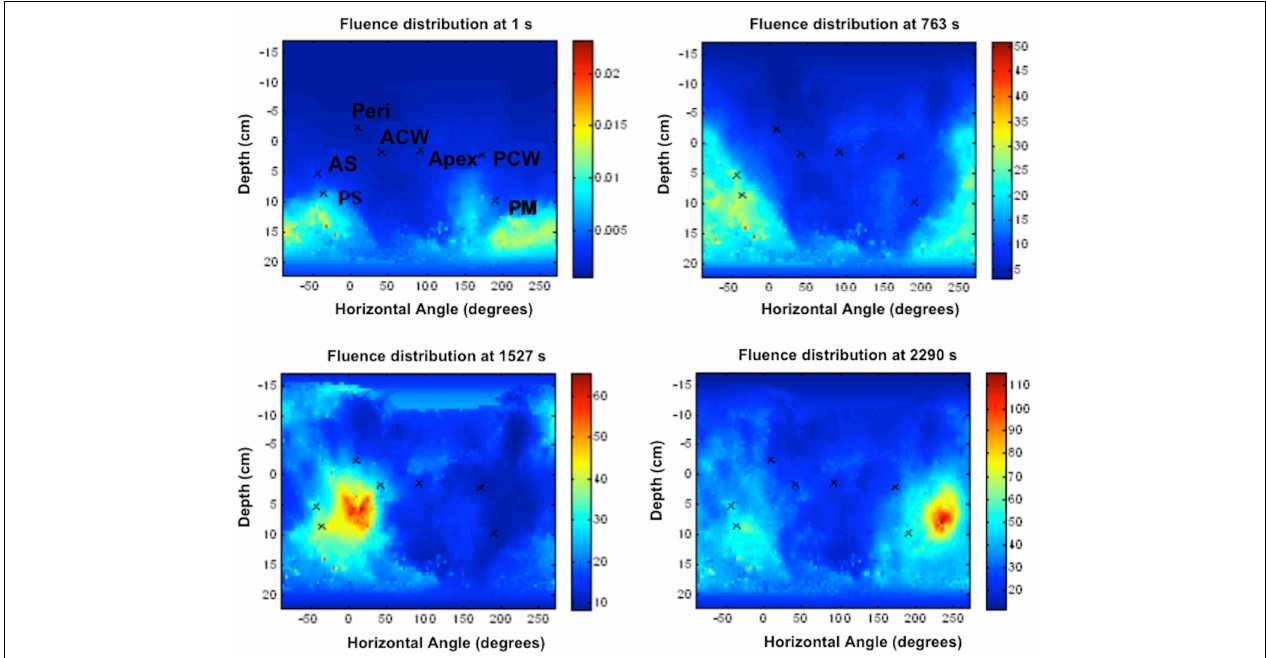
FIGURE 11 | Calculated spatial distribution of light fluence for a patient with dual correction at various time points during the PDT treatment: t = 1 s, 763s, 1527s, and 2290s. The seven isotropic detector locations